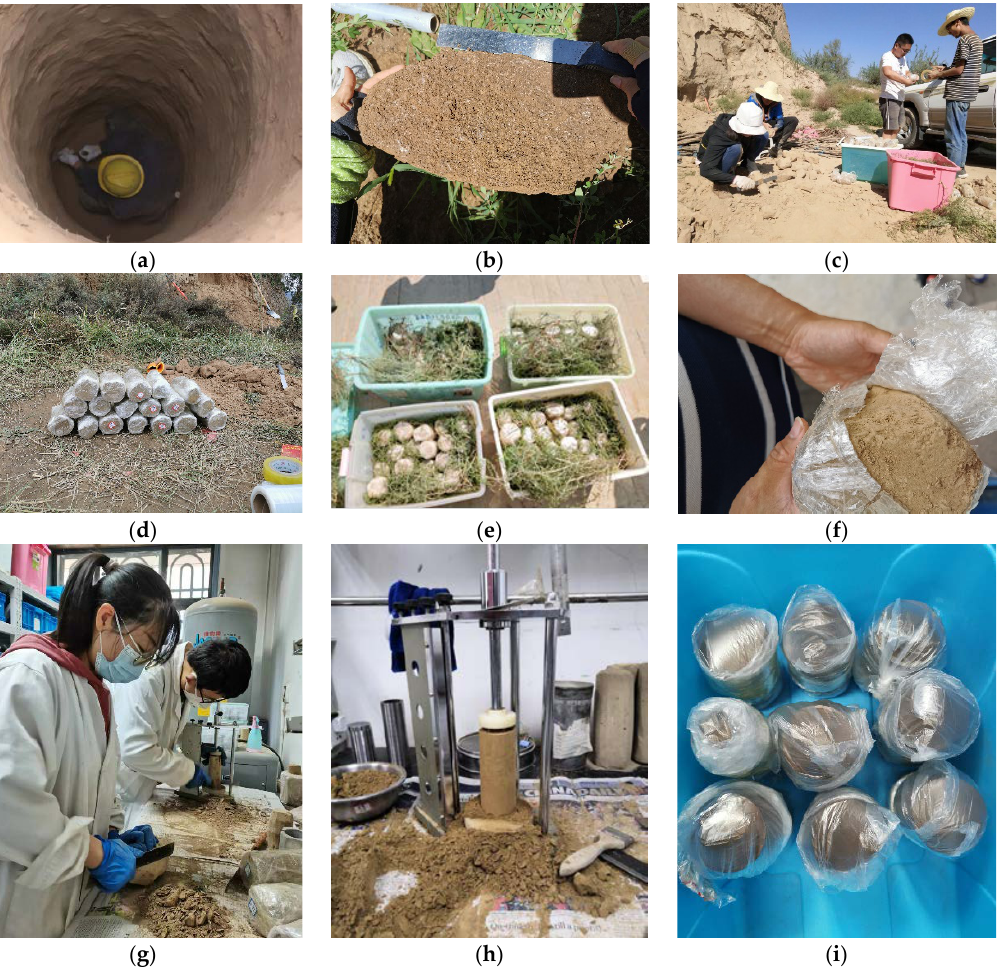
Figure 3. Process of sample collection and specimen preparation: ( a ) sampling in the exploration well, ( b ) the clod sample, ( c ) cutting the samples in the field, ( d ) cylinder samples wrapped with plastic cling film and taped, ( e ) samples placed in boxes, ( f ) removed plastic film, ( g ) preparing process of the specimens, ( h ) cylinder specimen after cutting in radial, and ( i ) the specimens with plastic bags in a box.